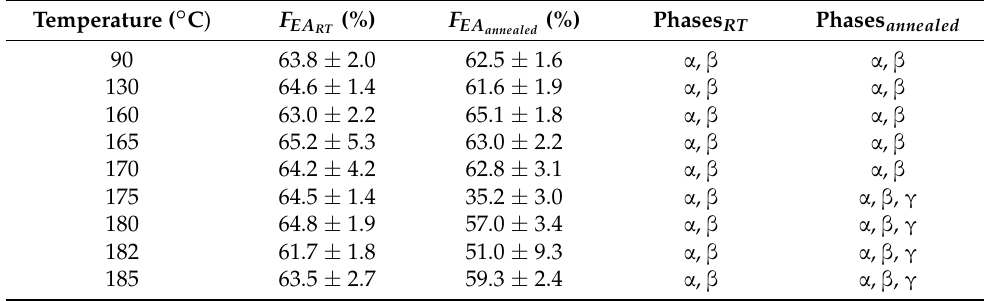
Table 2. Calculated fraction of the electroactive phases F EA (Equation (3)) and observed phases (n =